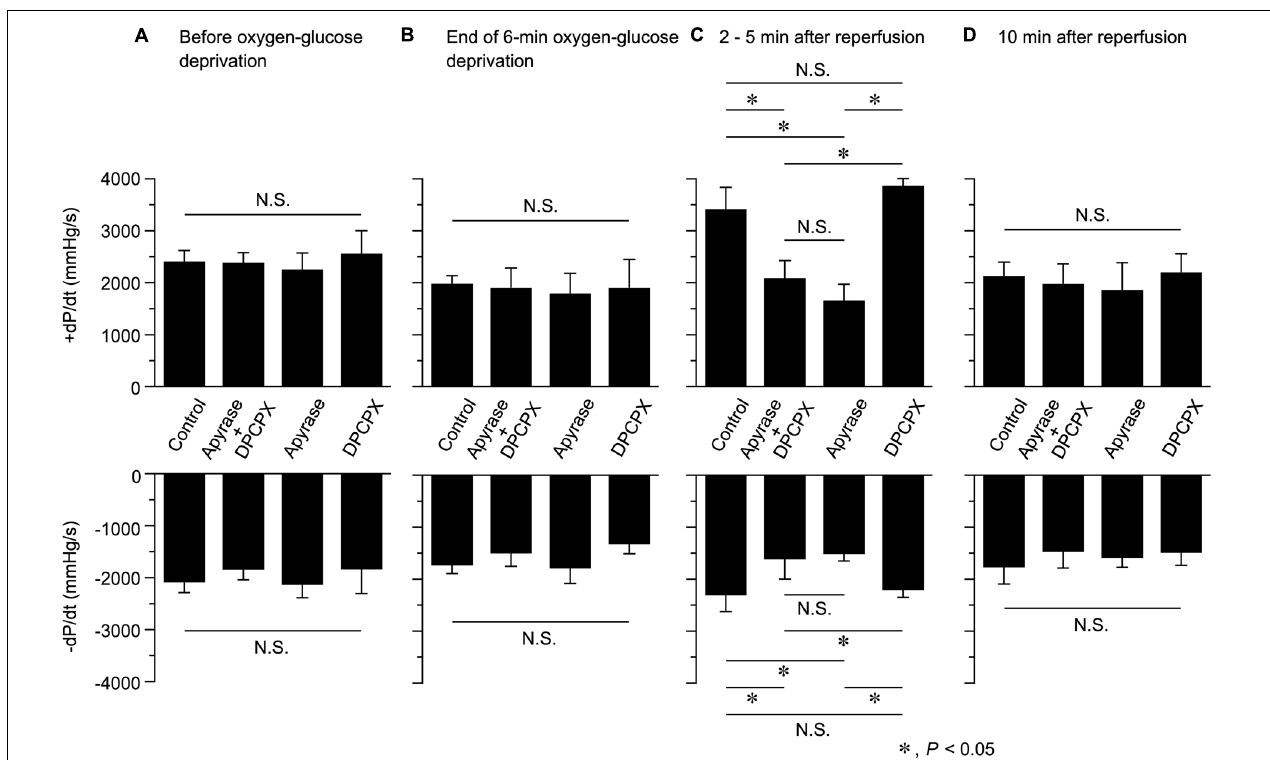
FIGURE 4 | Effects of apyrase and DPCPX added together or separately to the perfusion medium on the rate of left ventricular pressure development (+d P /d t , upper panel) and decline (-d P /d t , lower panel), measured before (A) and at the end of 6-min oxygen-glucose deprivation (B) , and at 2–5 min (C) and 10 min (D) after reperfusion ( n = 4 in each group; using 16 mice in total). These data were obtained by analyzing the results presented in Figure 3 . * P < 0.05; N.S. = not